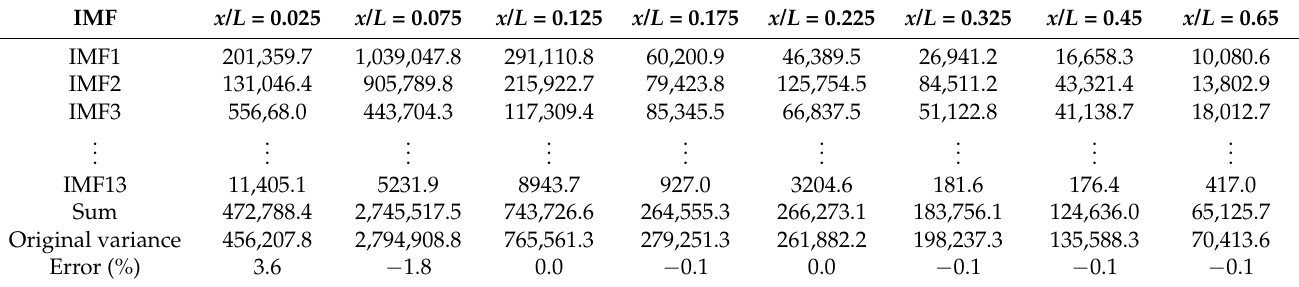
Table 7. Statistical table of signal variance decomposition (Pa 2